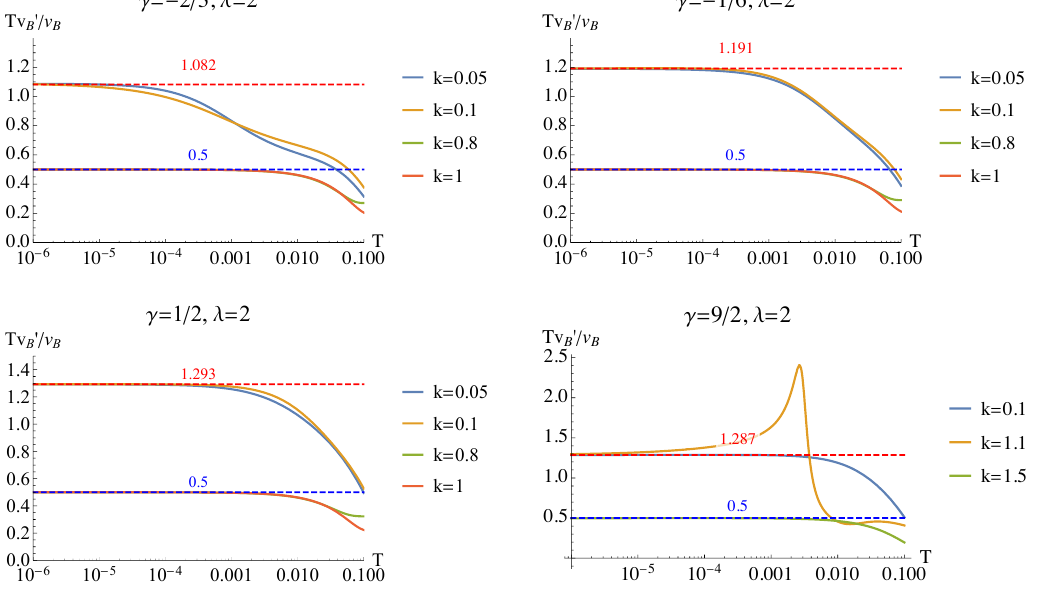
R , for which α = 1 / 2 . The red dashed 2 × 2 . 9+2 γ + γ 2